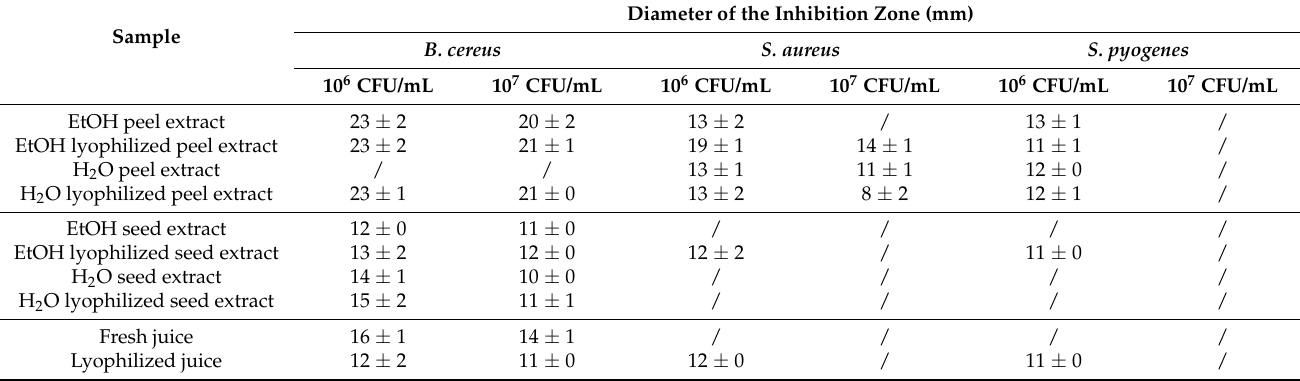
Table 4. Antibacterial activity of P. granatum samples on Gram-positive bacteria.